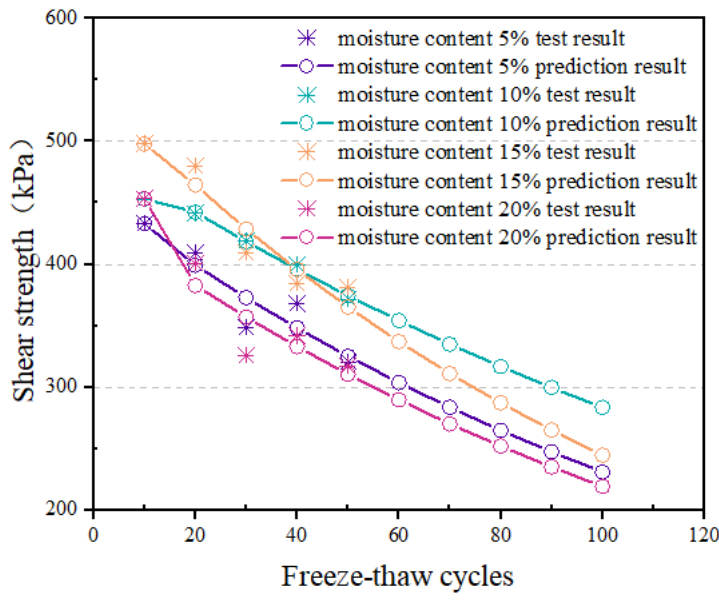
Figure 7. Actual and predicted values of peak tailings stress.